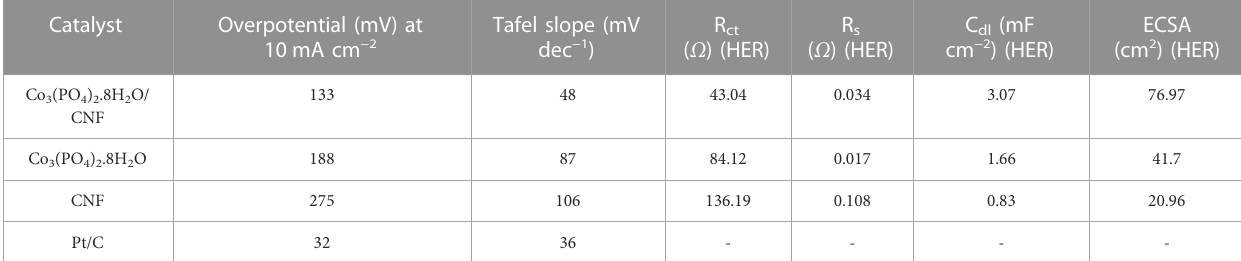
TABLE 1 Summary of the electrochemical HER activity of Co 3 (PO 4 ) 2 .8H 2 O/CNF, Co 3 (PO 4 ) 2 .8H 2 O, CNF, and Pt/C catalysts in the acidic medium.